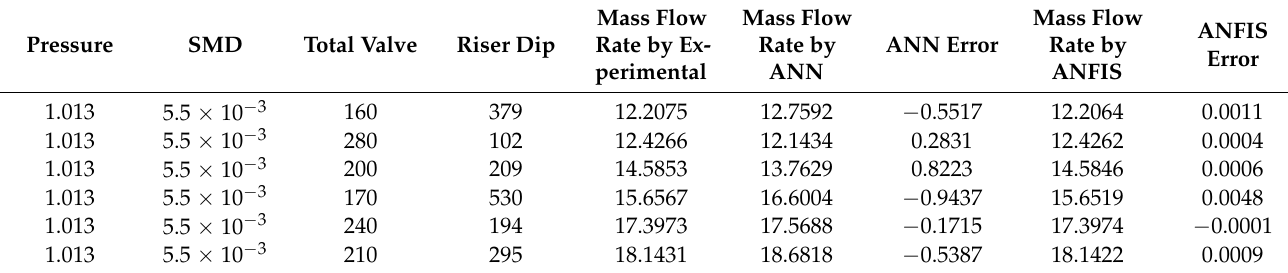
Table 8. Random prediction of samples for testing ANN and ANFIS model. Table 9. Comparison analysis of ANN and ANFIS.